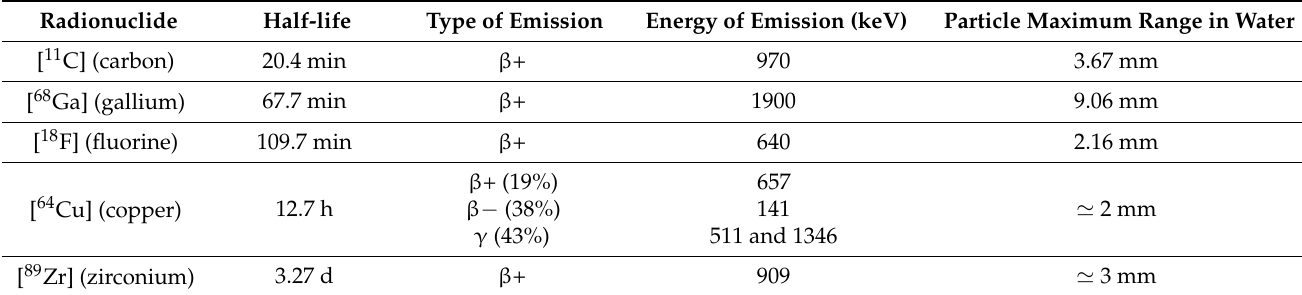
Table 1. Characteristics of key radionuclide use for the development of new radiotracer in the immunotherapy field. Radionuclide